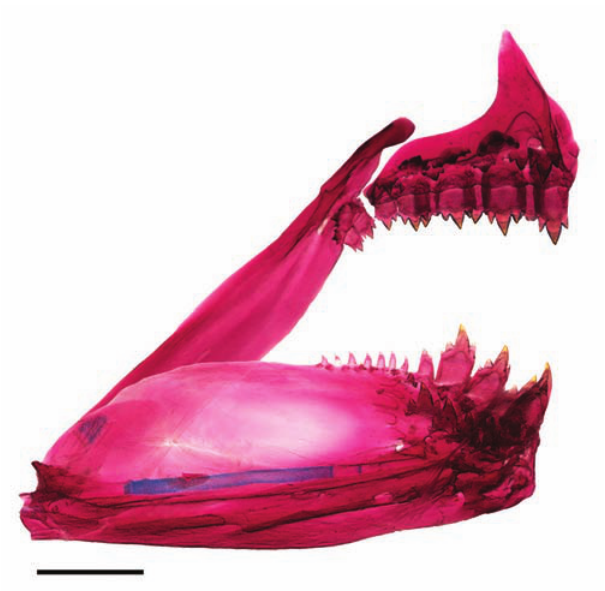
Fig. 2. Medial view of left side, upper and lower jaws of Hemigrammus ataktos , MZUSP 47846, paratype, 33.7 mm SL. Scale bar = 1 mm.